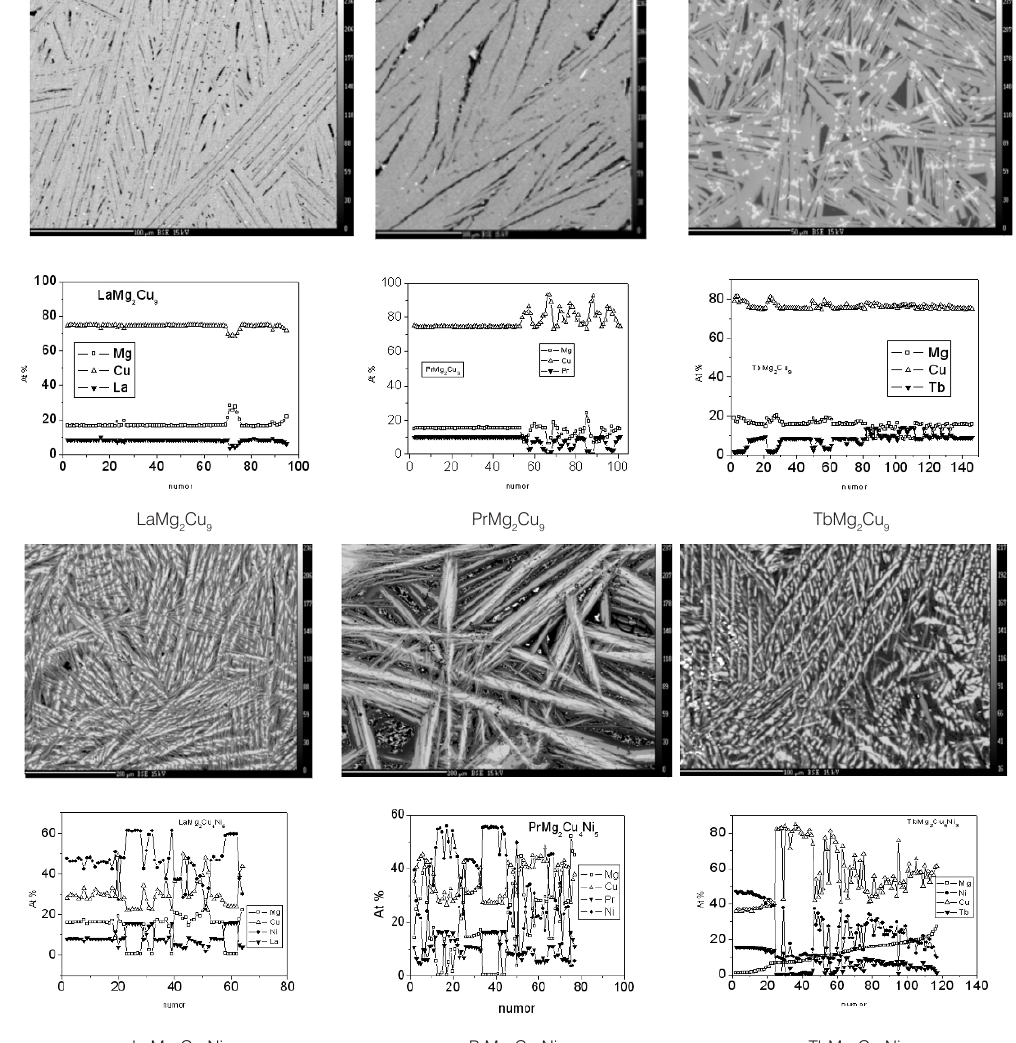
Figure 1. EPMA micrographies of the microstructure of the